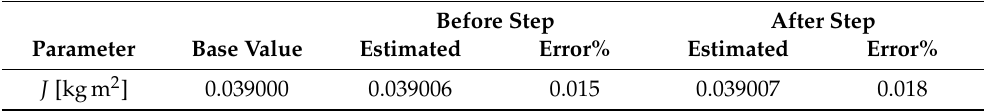
Table 3. N-MRAS_e results before and after step 1 and step 2 changes.